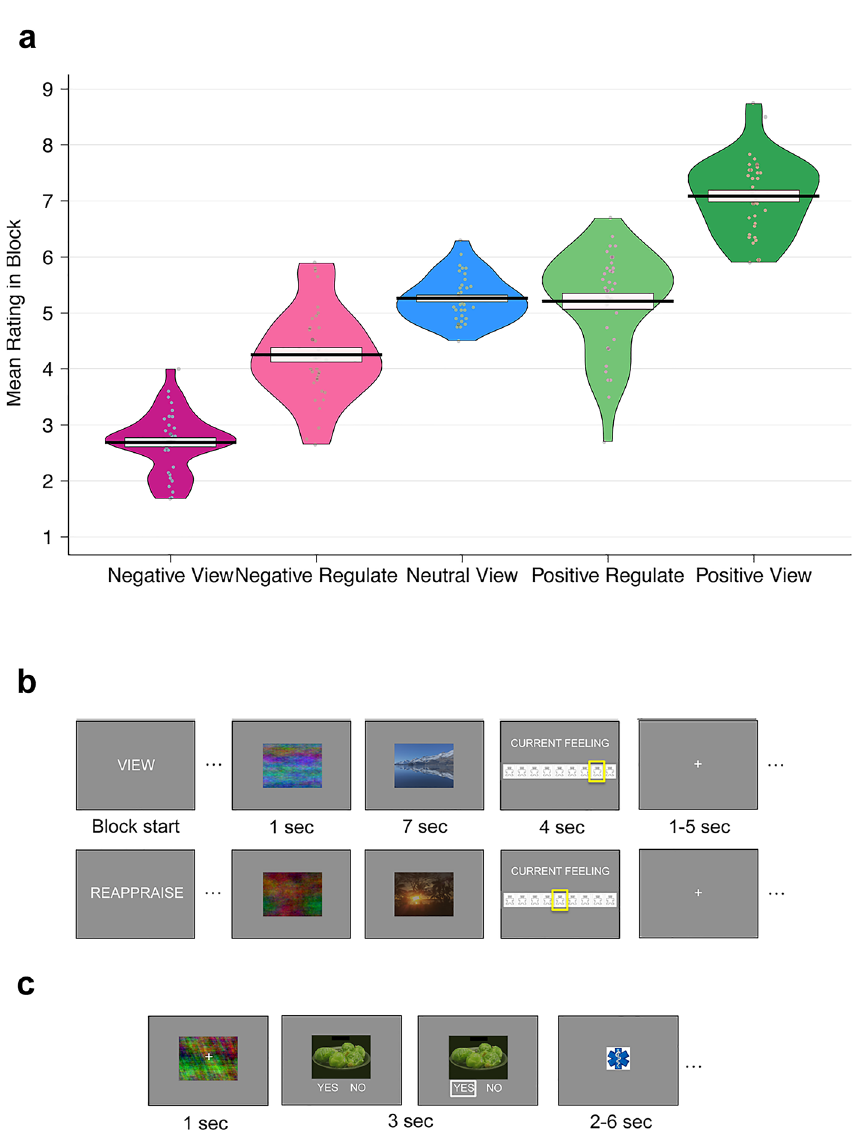
Figure 1. Self-regulation tasks and behaviour. ( a ) Emotion reappraisal success. On the 9-point SAM scale, the panel shows the mean emotion ratings for each block (negative view, negative reappraise, neutral view, positive reappraise, and positive view blocks). The black solid line indicates the group mean and the box its standard error. Each grey dot represents the mean ratings from one participant. Participants successfully reappraised both negative and positive images, shifting their feelings in both cases towards a neutral state. ( b ) Emotion reappraisal task. Participants saw positive, neutral and negative stimuli from the International Affective Picture System (IAPS). For display purposes, we replaced the IAPS stimuli by unrelated landscape photos here. In each block, participants either viewed the images without changing their emotional response (“view”) or reappraised the scene to render their feelings more neutral (“reappraise”). To allow the pupil to adapt to brightness and contrast, a phase-scrambled version of the stimulus was displayed for 1 s before the image was revealed. Participants then viewed or reappraised the scene for 7 s before they rated their current feeling on a Self-Assessment-Manikin (SAM) scale (for details see “Materials and methods”). A jittered inter trial interval of 1–5 s separated the trials. ( c ) Dietary health challenge task. Participants made 100 choices indicating whether they wanted to eat the displayed food at the end of the study. A phase-scrambled adaptation stimulus was presented for 1 s before the food image was revealed and participants had 3 s to decide by pressing the left or right button for selecting the answers “yes” or “no”. A white frame highlighted the answer for 0.1 s when it was logged. Trials were separated by a 2–6 s (jittered) inter-trial